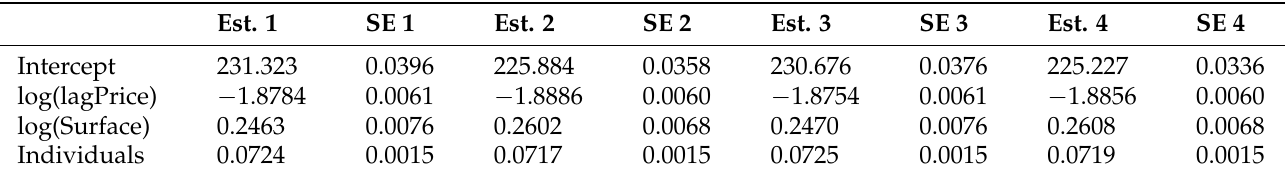
Table A1. Mixed model estimation results. Randomness in the intercept.